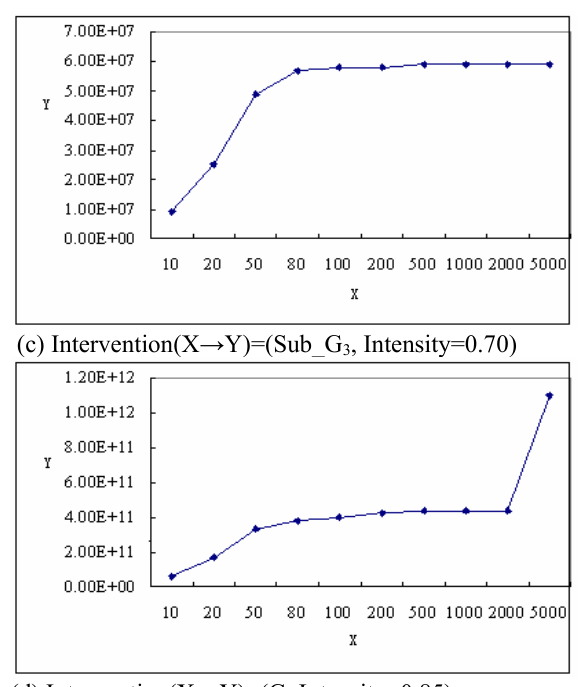
Fig. 5 Intervention rules in different decomposed sub graphs and the original